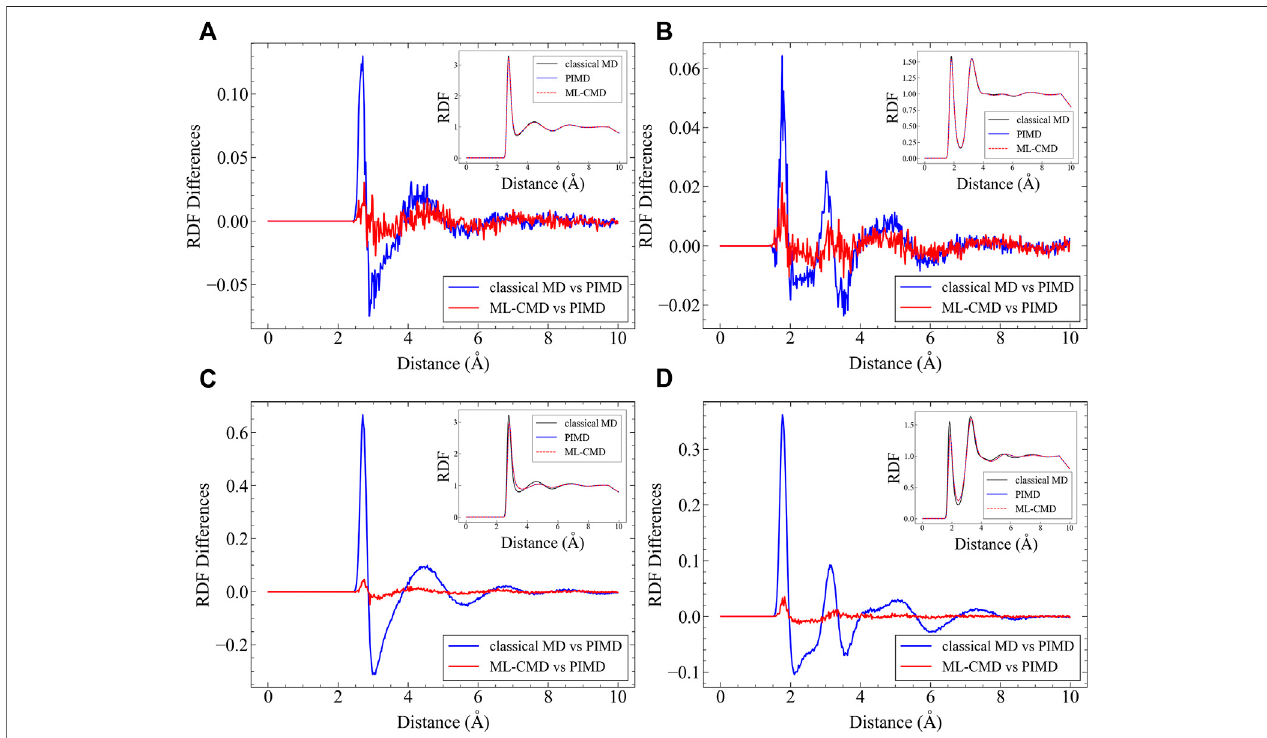
FIGURE3| ComparisonbetweendifferentcentroidRDFs.Ineach fi gure,theRDFdifferencesbetweenML-CMDandPIMDareshown,inconjunctionwiththeRDF differences between classical MD and PIMD. The corresponding RDFs are all plotted in the inset. (A) The O-O RDF in q-TIP4P/F simulations; (B) the O-H RDF in Sq- TIP4P/F simulations; (C) the O-O RDF in AMOEBA simulations; and (D) the O-H RDF in AMOEBA simulations.